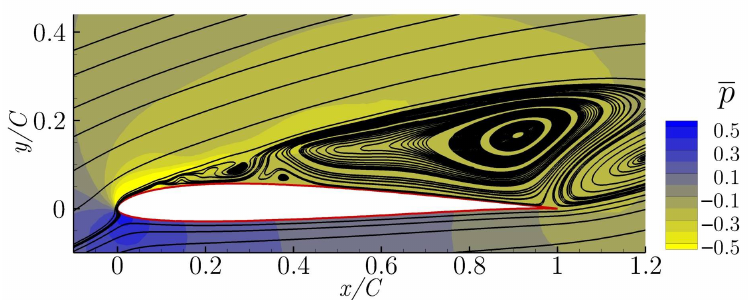
Figure 5. Averaged streamlines and pressure field of the Case 1 ( C l =